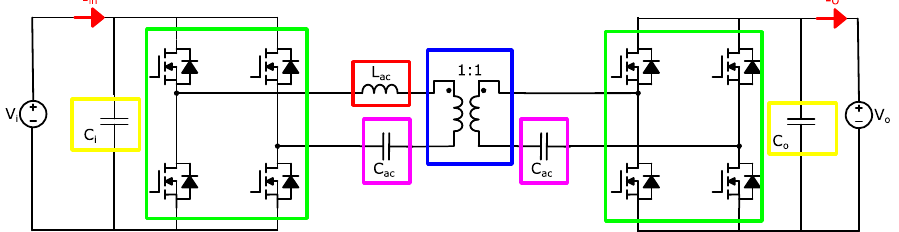
Figure 3. Dual Active Bridge (DAB) topology used as scenario study. Colored scares are highlighting the main components’ types.